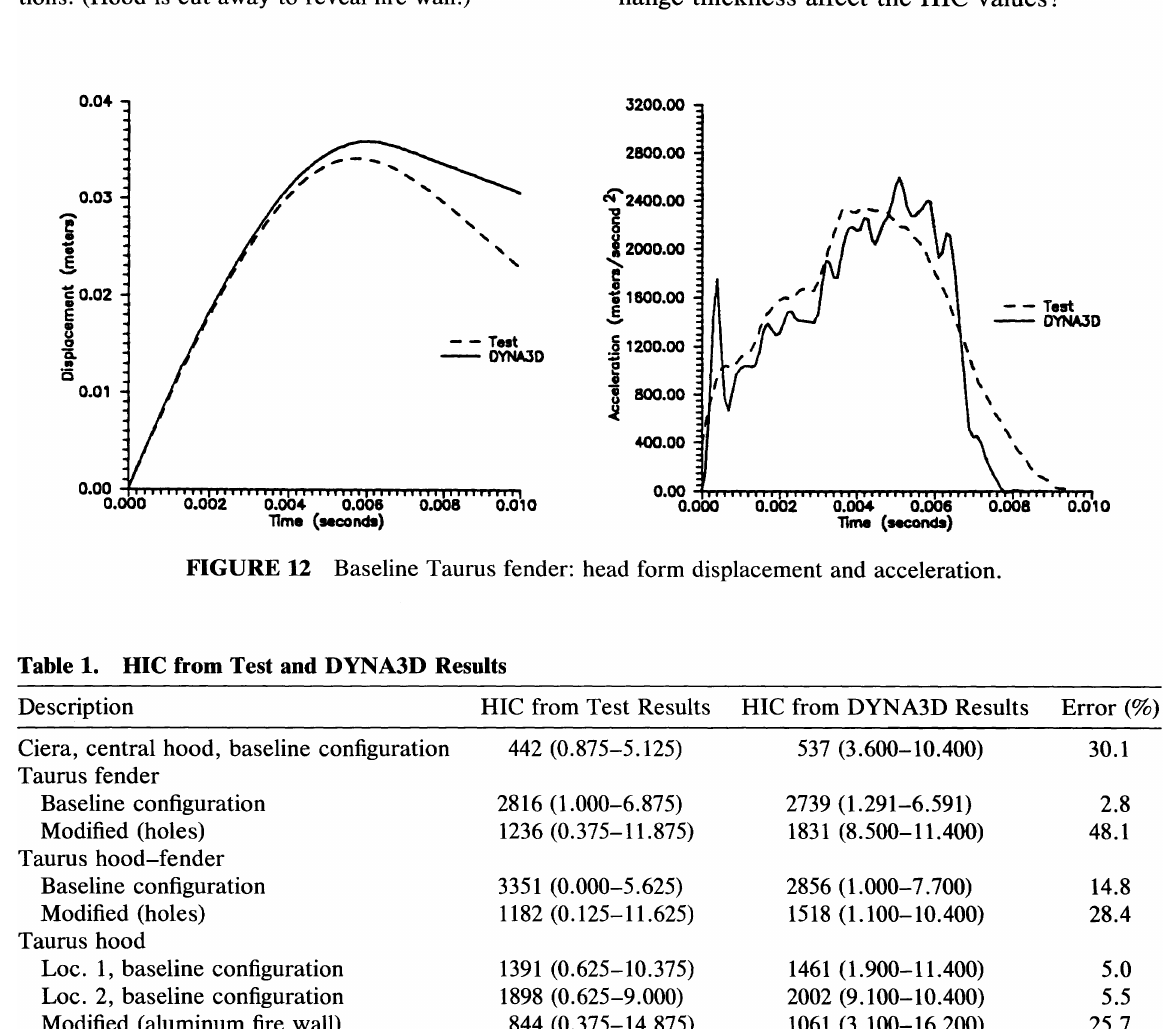
Table 1. HIC from Test and DYNA3D